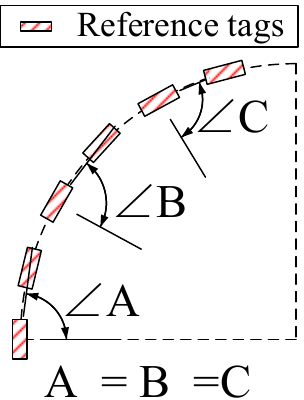
Figure 5. Part of UCA using the optimized relative position.